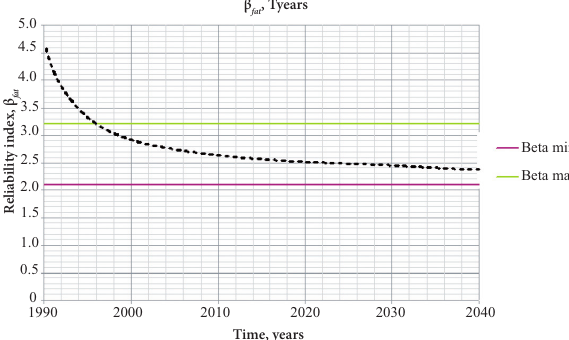
Fig. 11. Probabilistic modelling of the likelihood of failure, rivets of the short diaphragm connection – detail 2 (shear detail category as suggested in section 3, C = 110) for a max stress excursion of 77